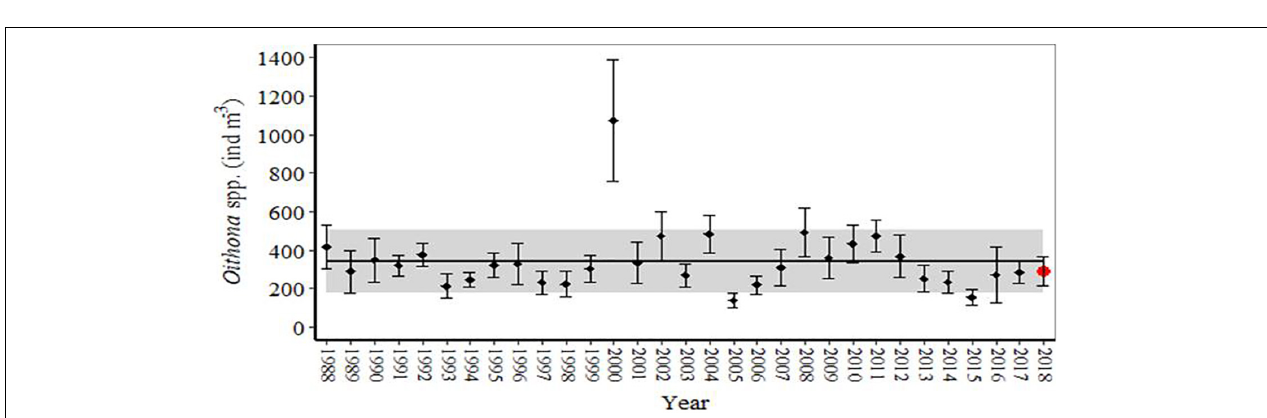
FIGURE 2 | Mean ( ± SE) annual Oithona spp. density for each year of the L4 time series (1988–2018), compared against the mean ( ± SD) Oithona spp. density over the full time series. In the latter, the mean is represented by the solid line, and the standard deviation is represented by the grey band.